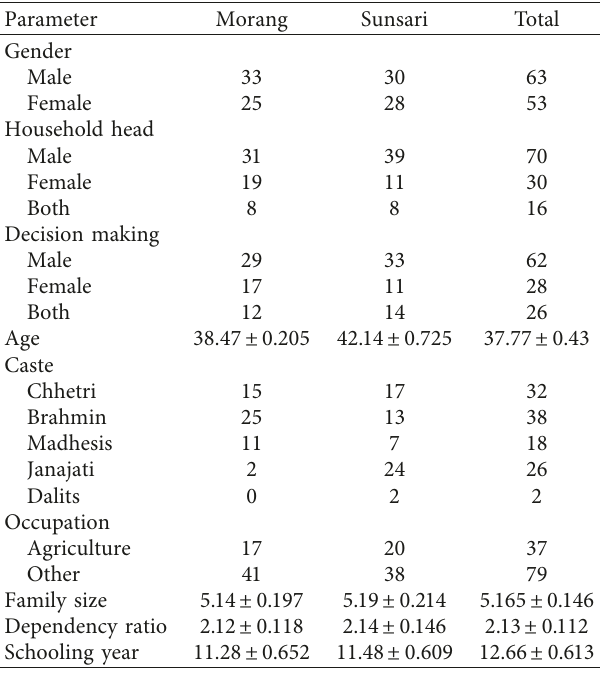
Table 4: Socioeconomic characteristics of the study area.